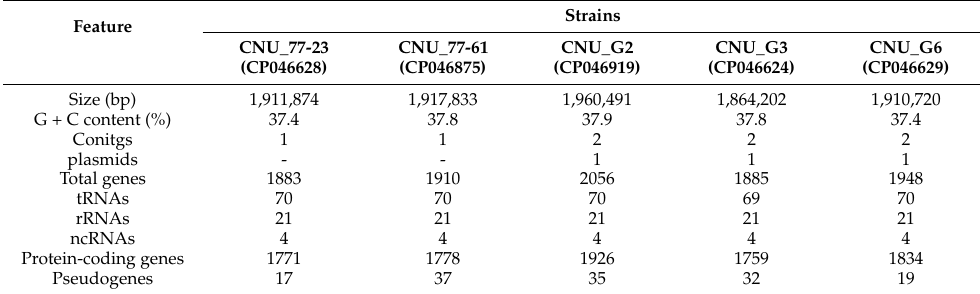
Table 4. The genomic features of five selected SBSEC